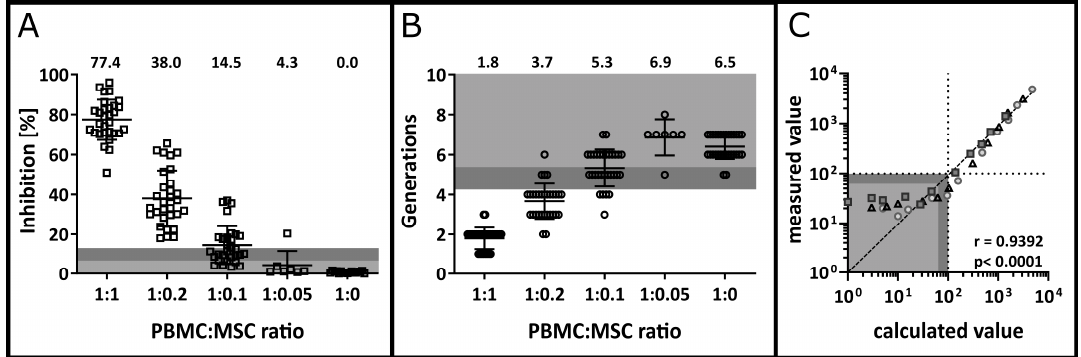
Figure 4. Detection limit and quantitation limit. ( A ) Dose-dependent inhibition of T cell proliferation by MSCs. PBMCs and MSCs were co-cultured in different ratios to define the lowest MSC concentration for which the inhibition of proliferation can still be detected. Based on the 1:0 ratio, a LOB of 6.8% and a LOD of 13.6% were determined and are highlighted by medium and light grey areas. Mean values for n = 30 (1:1, 1:0.2, 1:0.1, 1:0) or n = 7 (1:0.05) are indicated above the plot. ( B ) Number of detectable T cell generations with respect to MSC co-incubation at different ratios. The LOB at 5.4 generations and the LOD at 4.3 generations were calculated based on T cell generations in the absence of MSCs and are highlighted within the plot in light and medium grey ( n = 30 and n = 7 for 1:0.05). ( C ) Determination of the LLOQ for one daughter generation. Anti-CD3 and anti-CD28 co-stimulated cells were spiked into unstimulated cells as a negative control for an undivided generation. A dilution series was performed, and the calculated value of divided PBMCs was plotted against the number of detected events (measured value). Data were obtained in three independent experiments. Circles, squares and triangles represent data obtained within one titration experiment, each. Values below the LOD of 97 events and the LOB of 62 events are highlighted in light and medium grey, respectively, and the LLOQ of 100 events is indicated by the dotted lines. The dataset was analysed by computing the Spearman correlation coefficient (r = 0.9392, p < 0.0001).